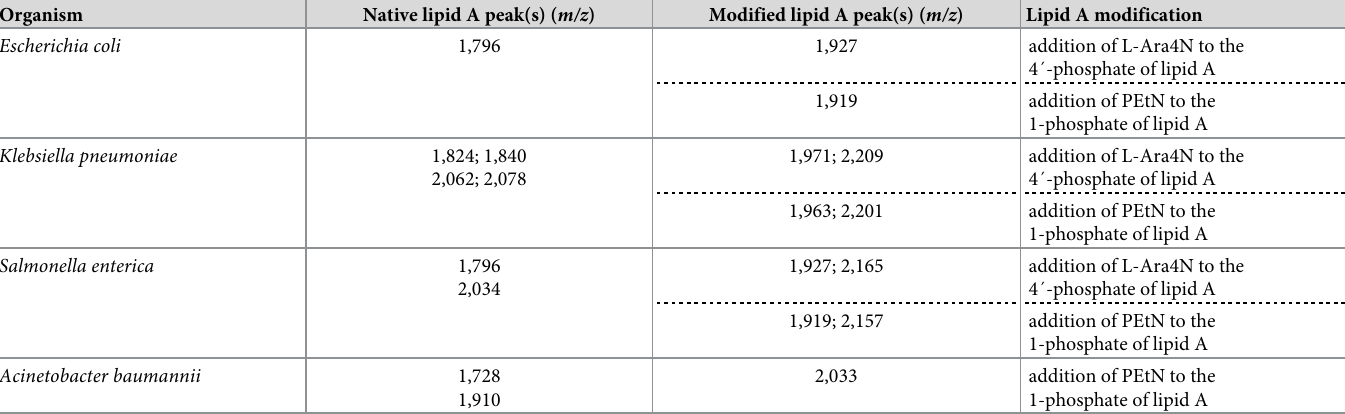
Table 1. m/z values rounded to the nearest decimal for native and modified lipid A peaks obtained by MALDI-TOF mass spectrometry from intact colonies of gram-negative bacterial pathogens that are commonly resistant to colistin.